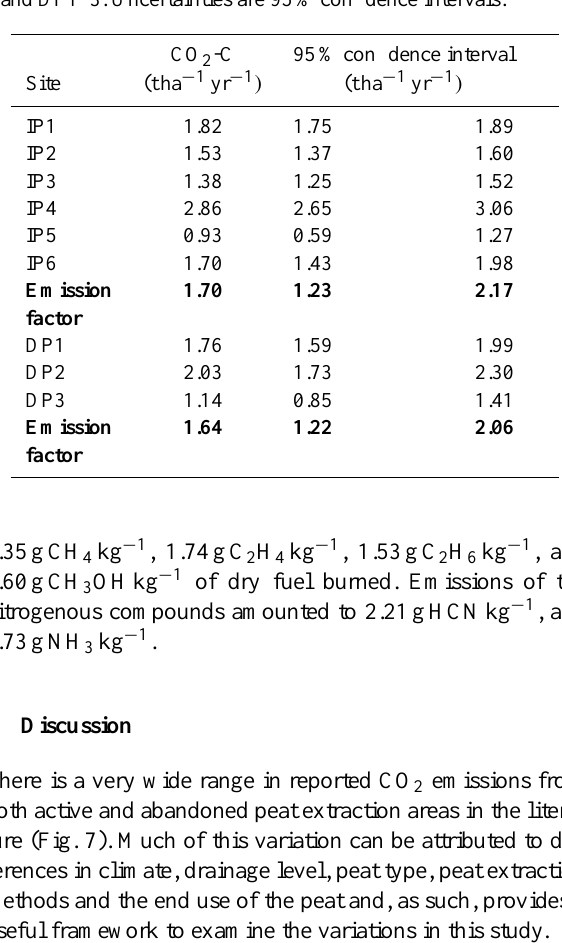
Table 2. Emission factors (tonnes CO 2 -Cha − 1 yr − 1 ) for sites IP1– 6 and DP1–3. Uncertainties are 95% confidence